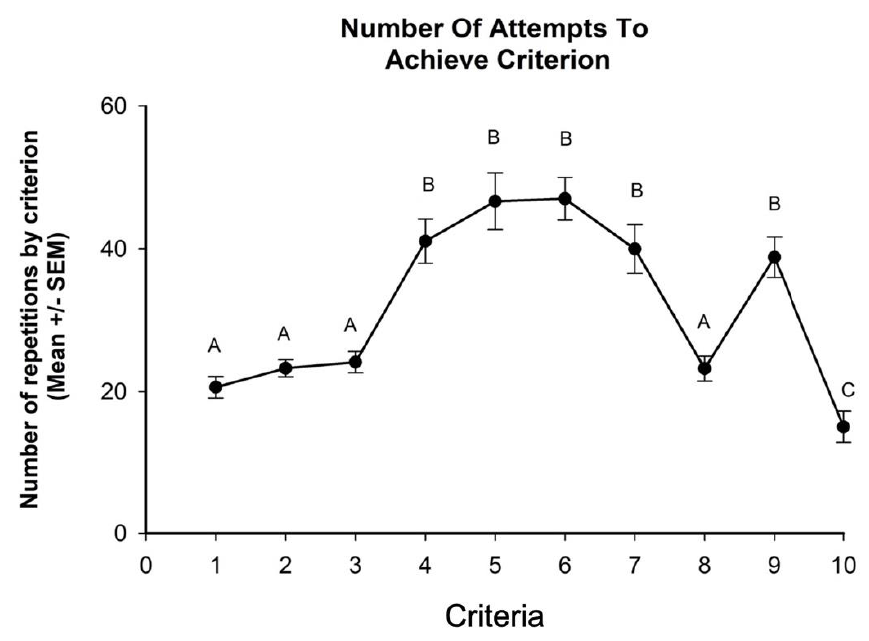
Figure 3. Fetch training was divided in 10 successive criteria. Piglets needed to achieve the criteria in order to progress to the next step. Statistical analysis detected differences in the number of repetitions required to achieve criteria. Different capital letters indicate significant differences p < 0.05.